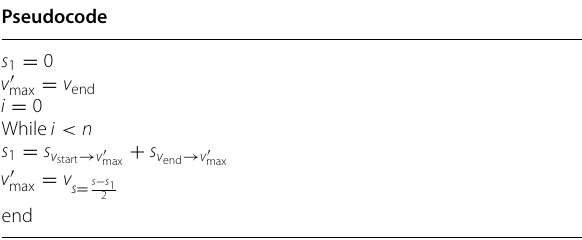
Table 1 Pseudocode of double-quartic polynomial trajectory planning